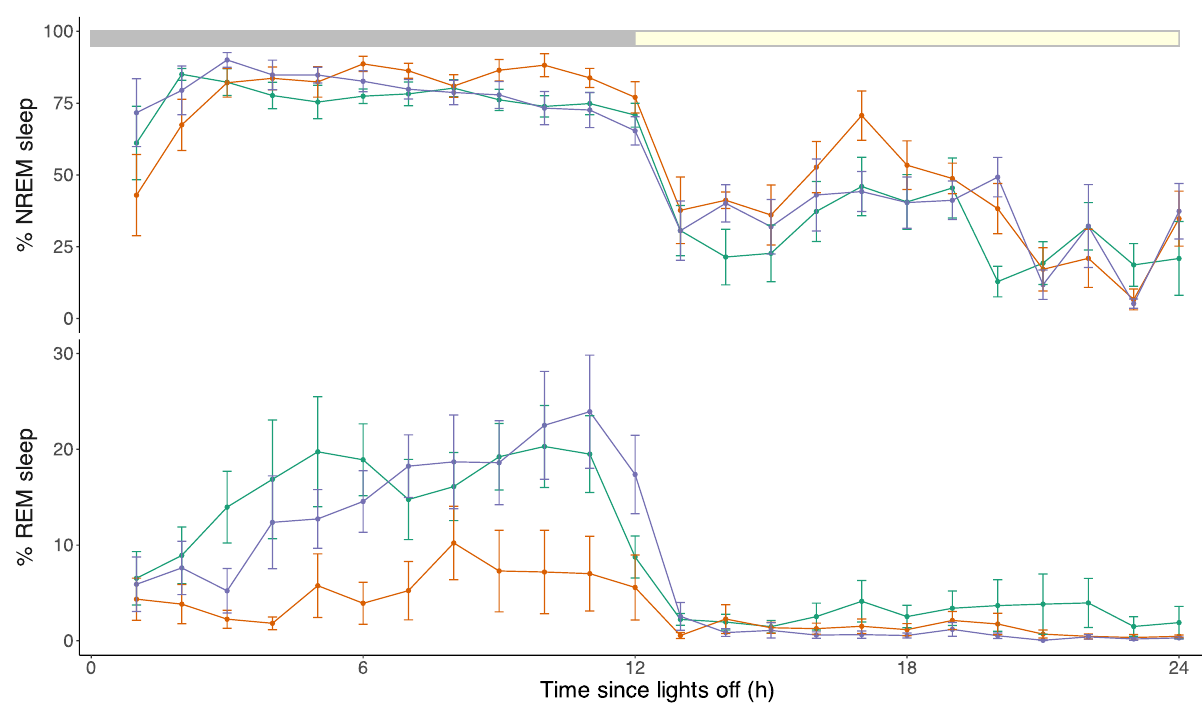
Figure 5. Effects of cold exposure on sleep – wake patterns in tree shrews: ( upper panel ) amount and distribution of NREM sleep; ( lower panel ) amount and distribution of REM sleep. NREM sleep time was unaffected by the cold exposure (lm model, treatment: p = 0.48). REM sleep was suppressed from 15.3 ± 4.2% during the baseline night to 5.4 ± 3.0% during the cold night exposure (post hoc test after lm model, p < 0.001), without a rebound in REM sleep time during the recovery period (lm model, p = 0.65). The grey and yellow bar on top reflects the 12:12 light – dark cycle.